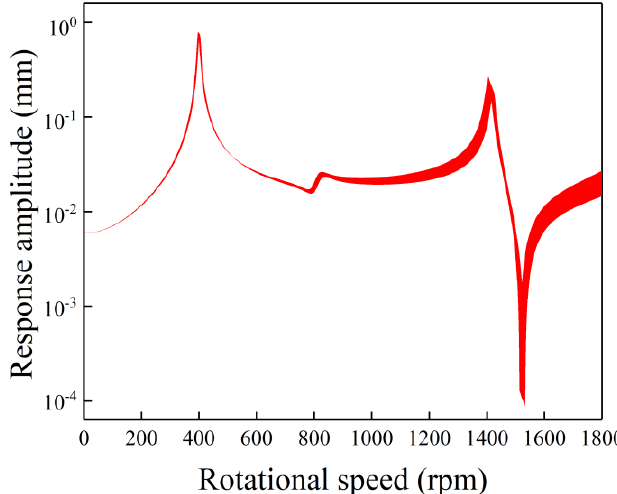
Figure 7. The bounds of uncertain gravity response versus rotational speed by the CIM with a 5% deviation in density.